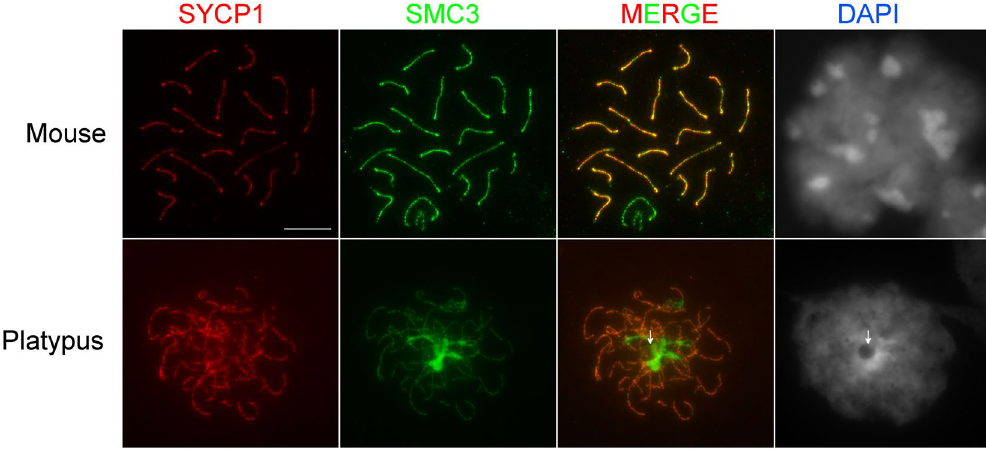
Figure 1. SMC3 and SYCP1 localisation in mouse (upper panel) and platypus (lower panel) pachytene cells. SMC3 localises to the axial core of all chromosomes while SYCP1 localises only to synapsed chromosomes, thus, the sex chromosomes appear as the only chromosomes exhibiting axial core signals without a central element signal. While the mouse signal on the sex chromosomes is as expected from published work, the signal in the platypus showed a significantly higher level of SMC3 recruitment on regions without a corresponding axial signal. This region also consistently associated with a large, spherical, DAPI poor region of the cell (white arrow). Scale bar = 10 µ